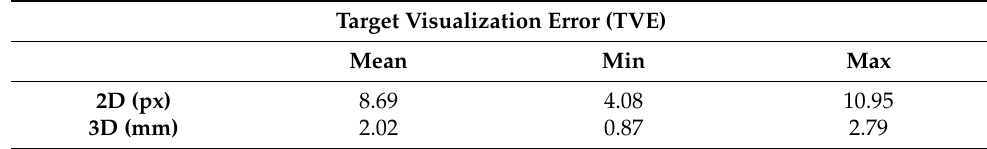
Table 1. Results of the AR overlay accuracy test in terms of TVE2D and